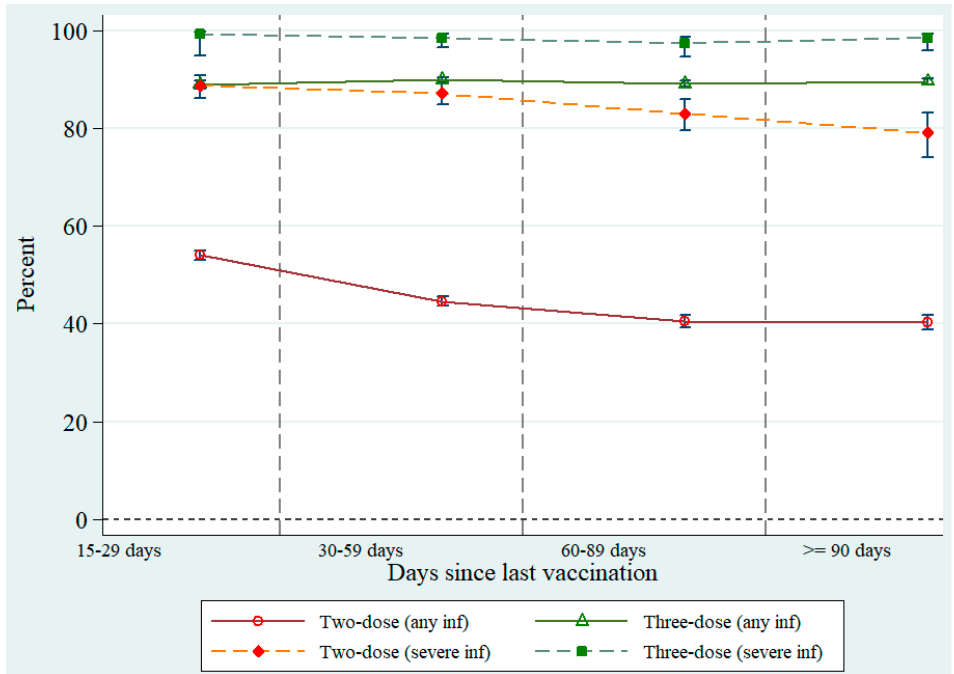
Figure 3. Vaccine effectiveness against any infection and severe infection among two- and three-dose vaccinees over time (any combination of vaccine brands). Note: Vertical bars denote 95% confidence interval; p < 0.001 for all schedules. Table 3. Vaccine effectiveness against any infection for two-dose and three-dose vaccine regimens sorted by time since last vaccination.